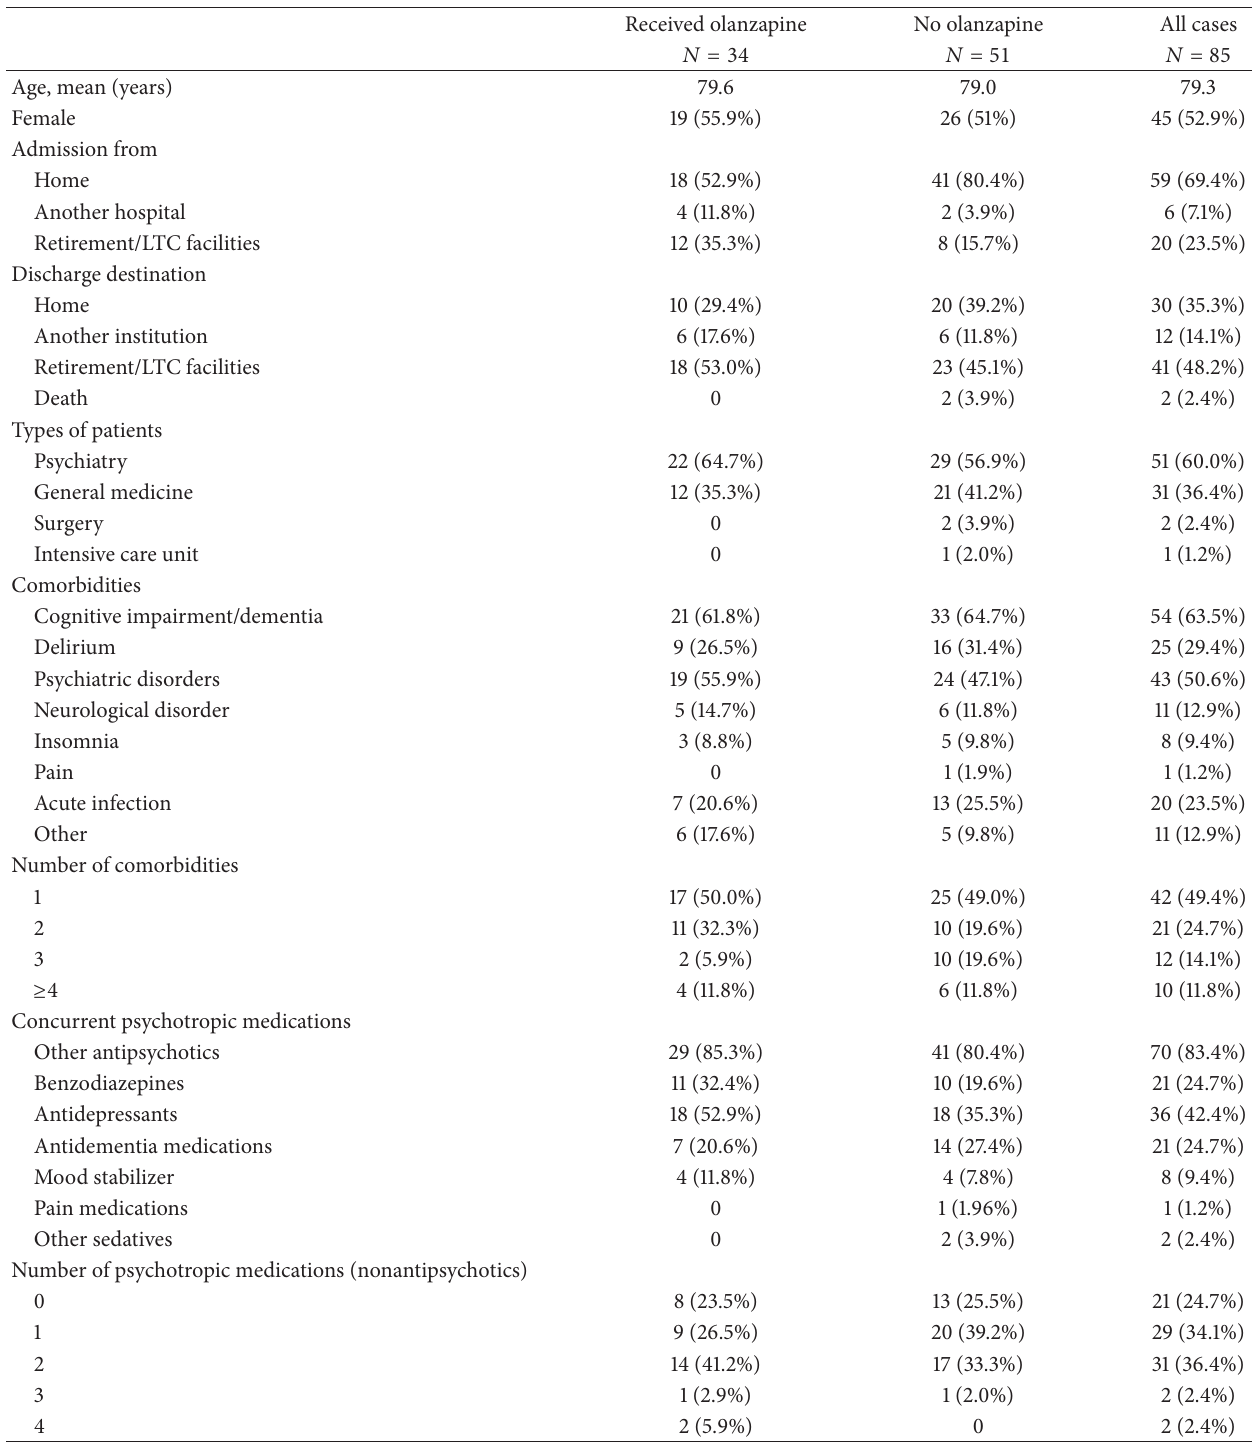
Table 1: Baseline demographic characteristics of older patients prescribed